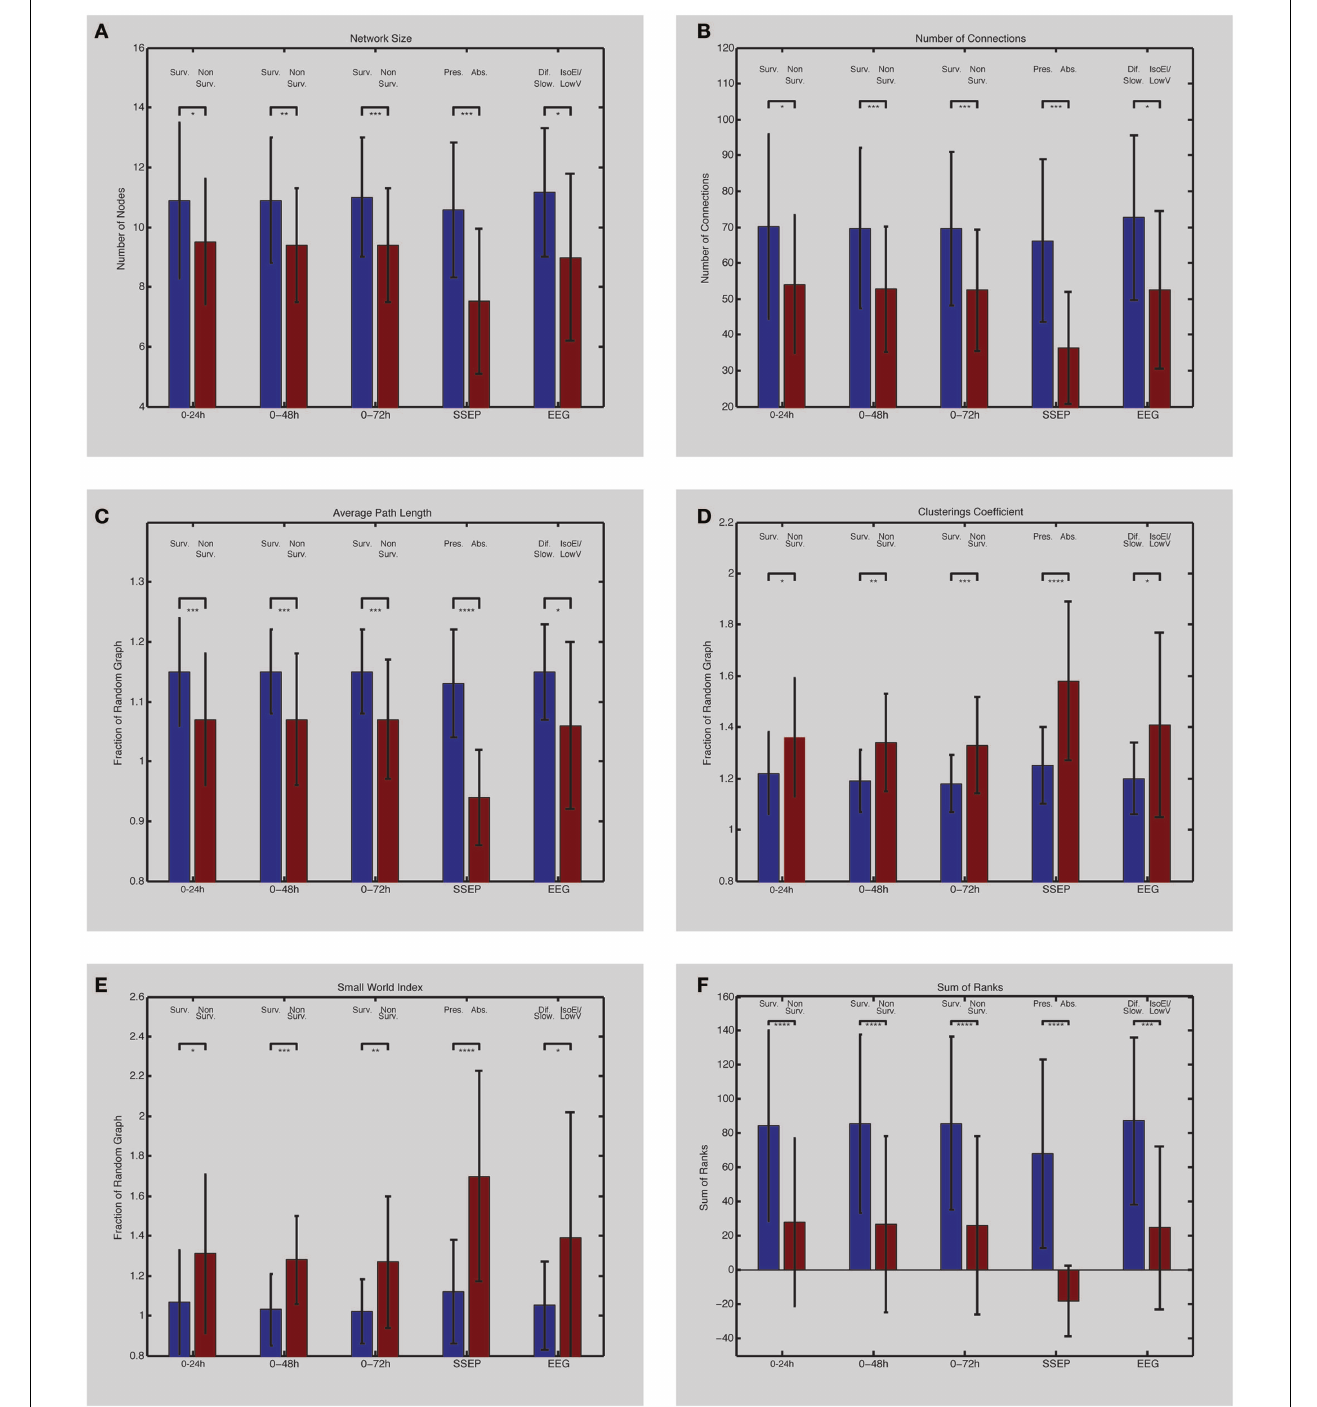
FIGURE 2 | (Left) EEG network characteristics of PAE survivors and non-survivors . Depicted are differences between survivors and non-survivors (first three bar couples) and their values between 0 and 24h (1), 0 and 48h (2), and 0 and 72h (3) after the arrest (forth bar couple); differences between patients with bilateral absent SSEP and uni- or bilateral present SSEP (fifth bar couple); differences between patients with iso-electric or low-voltage EEG and diffuse slowing on EEG. Network size (A) is defined by the number of electrodes present in the networks. Number of connections in the network is shown in (B) . Average path length